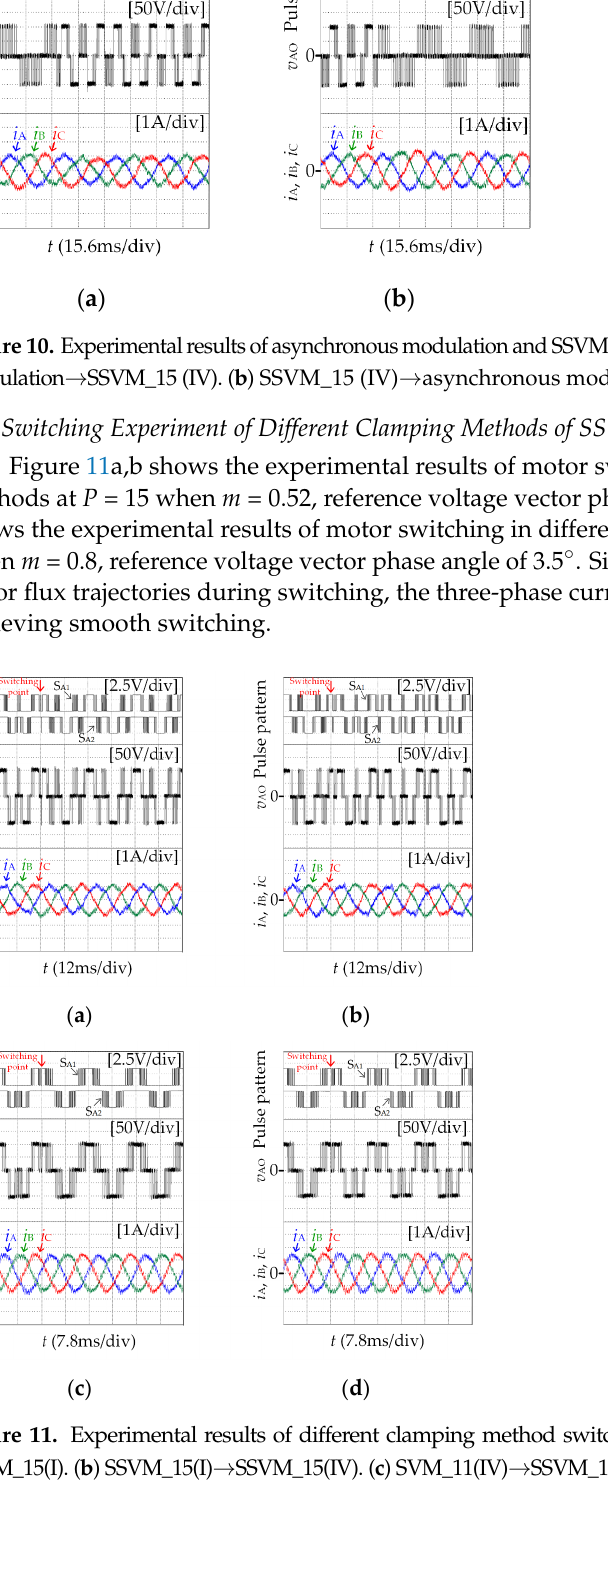
Figure 9. The prototype of dSPACE ® DS1007 driven three-level inverter.